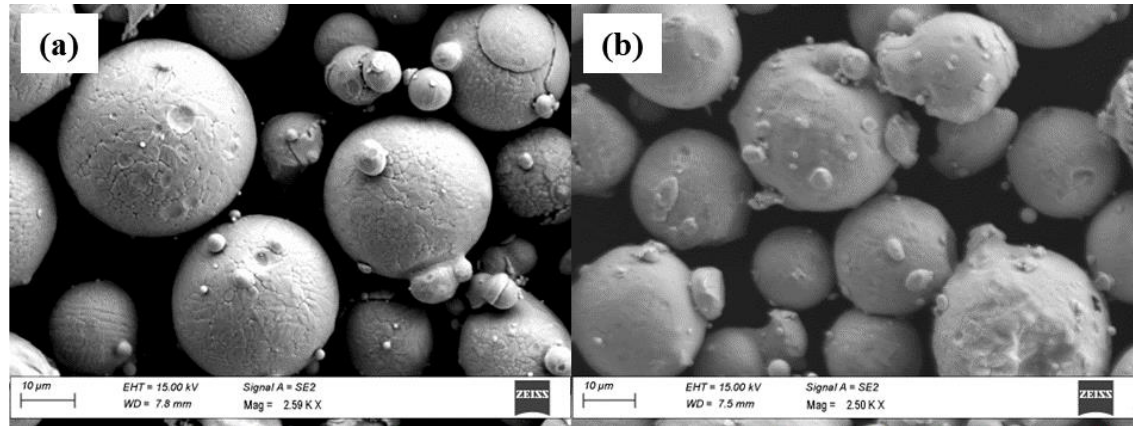
Table 1. Powder size and chemical composition (wt. %) according to the test method: ASTM E2594- 20.